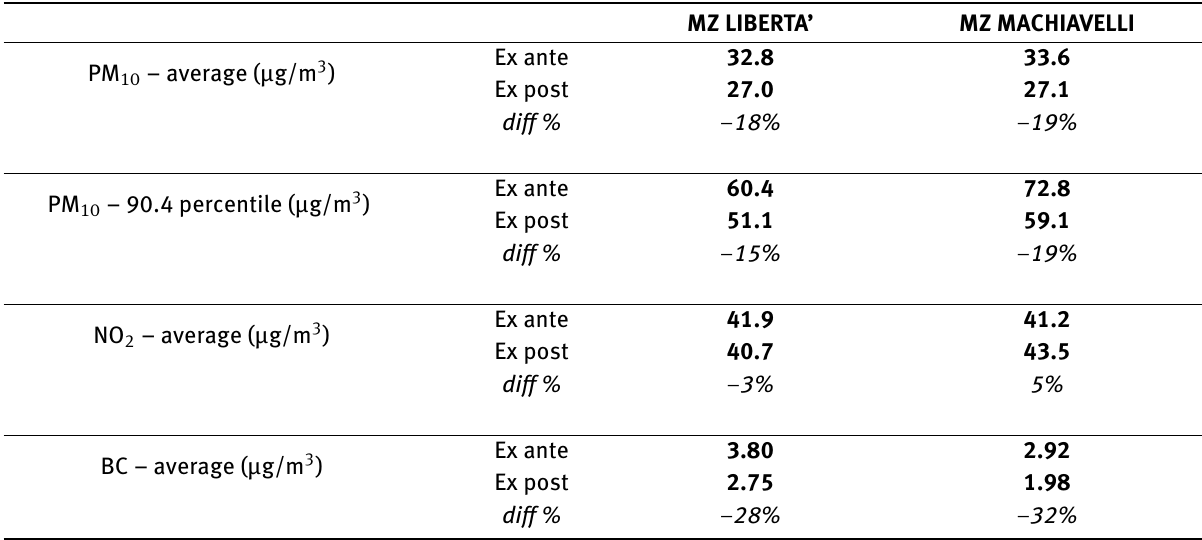
Table 7: NO 2 , PM 10 and BC mean values over the ex-ante and ex-post sampling period. Percent different comparison among measurement carried out inside (MZ-Libertà) and outside (Mz-Machiavelli) the Noise LEZ MZ LIBERTA’ MZ MACHIAVELLI PM 10 – average ( µ g/m 3 )